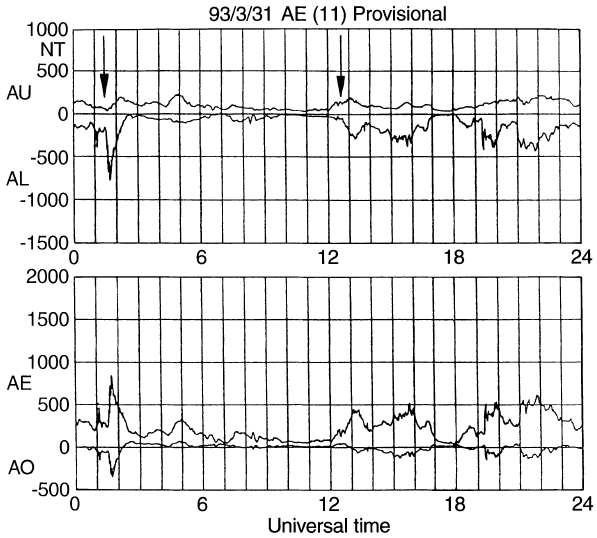
Fig. 2. The AE indices for the day 31 March 1993. The two arrows indicate the onset of the two substorms at 0133 UT and 1242 UT, detected prior to the two flux ropes centred at (cid:24) 0147 UT and (cid:24) 1307 UT.